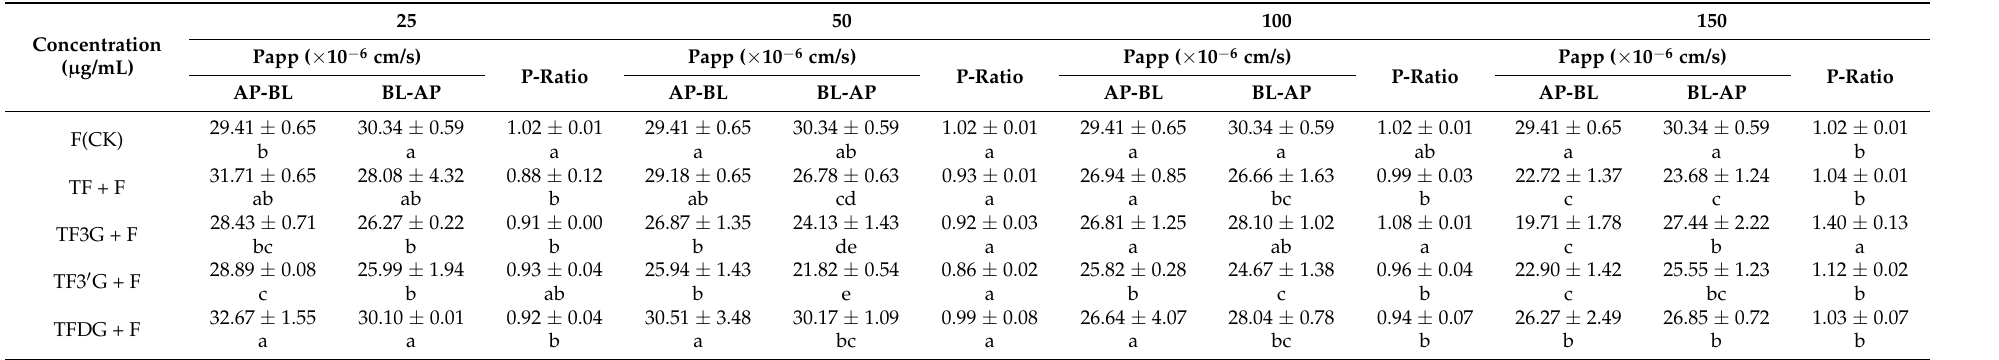
Table 2. Effects of different concentrations of TFs on the apparent permeability coefficient of F − transport in Caco-2